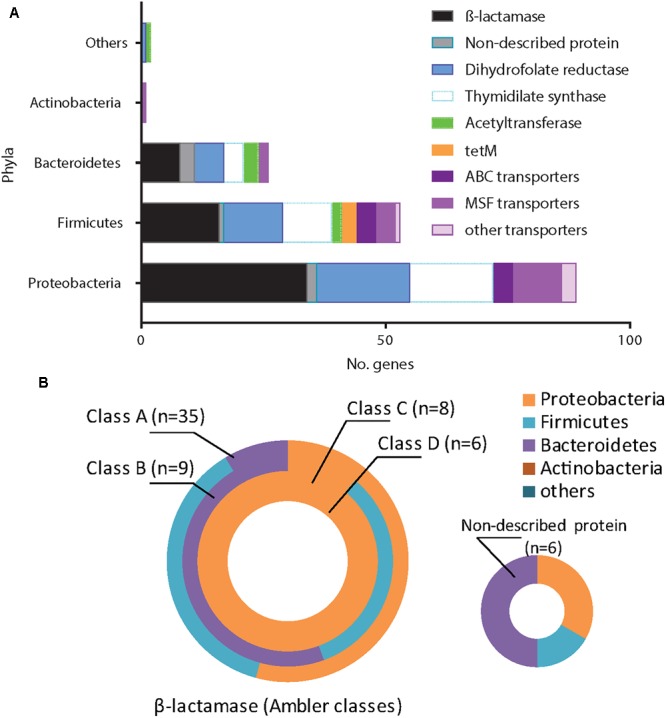
Antimicrobial resistance genes (ARG) and the related phyla. We related all identified ARG (n = 171) to the closest bacterial phyla using RAIphy on the contigs sequences obtained. Protein sequences were grouped according the main following families: β-lactamases (with Ambler classification), dihydrofolate reductases, thymidylate synthase, ribosomal protection protein, acetyltransferase, transporters/efflux pumps (ABC, MSF or others) and non-described proteins. We reveal the Proteobacteria, Firmicutes, Bacteroidetes, Actinobacteria, while other phyla are grouped into the “others.” (A) The majority of ARG came from Proteobacteria and Firmicutes. (B) Classes A and B β-lactamases were related to Proteobacteria, Firmicutes or Bacteroidetes while class C and D were exclusively related to Proteobacteria.